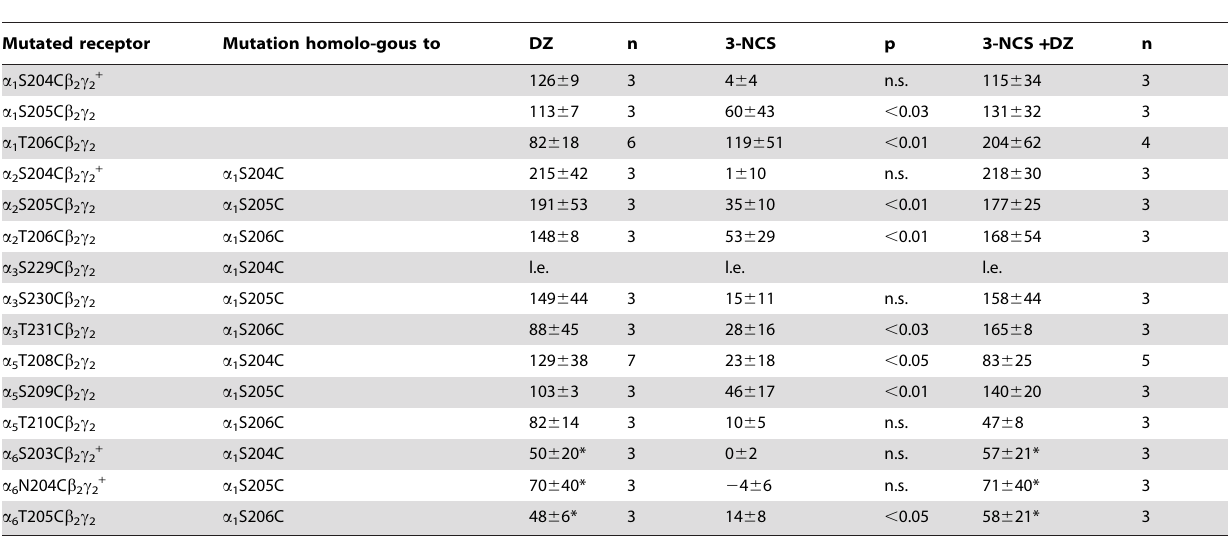
Table 2. Covalent reaction at the functional